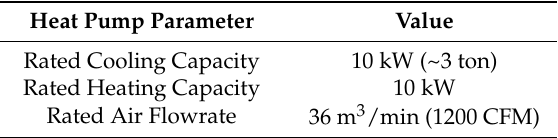
Table 3. Heat Pump